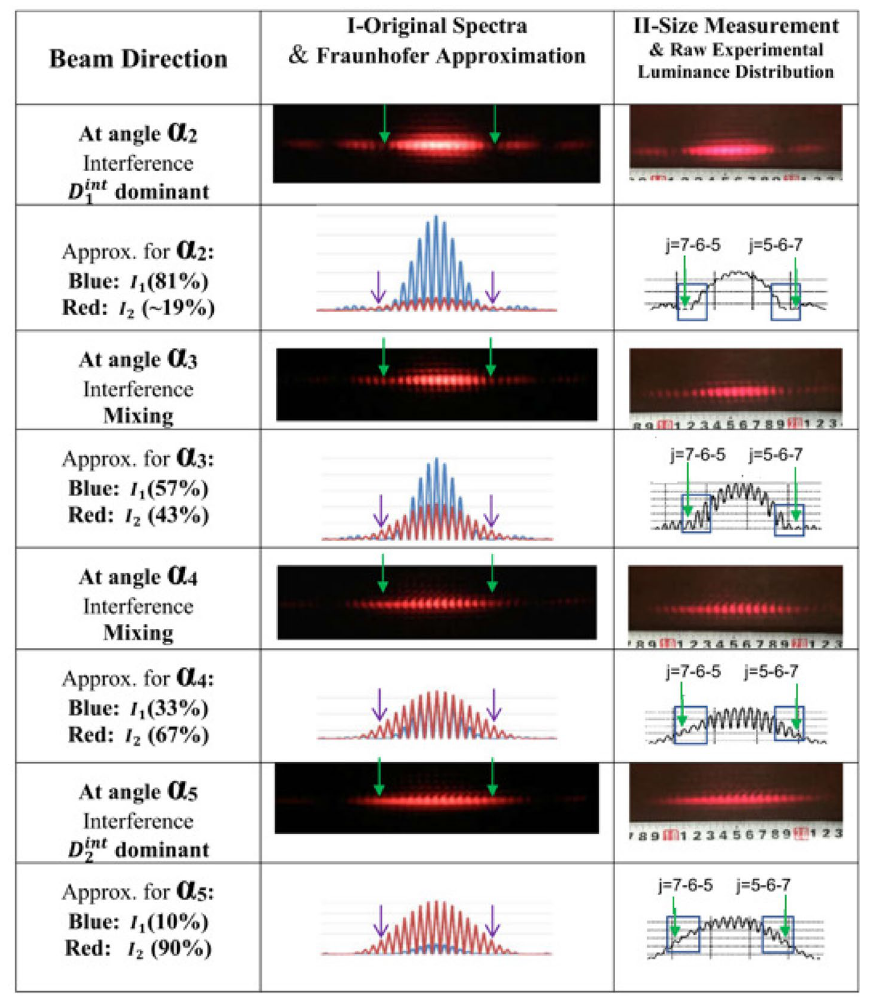
Figure 2. True ”which-way” signals: Direct observation of pure interference fringes with luminance I ( min .) of I 2 -photons passing through the narrow-slit (indicated by green arrows in spectra and Violet arrows in corresponding approximation curves). They are seen also in rectangular boxes with increasing luminance 7 ) (indicated by green arrows) together with their neighboring fringes with luminance I ( j I ( min . ) I ( j = = 5 ) when the laser beam changes its direction from α 2 to α 5 and I ( j =